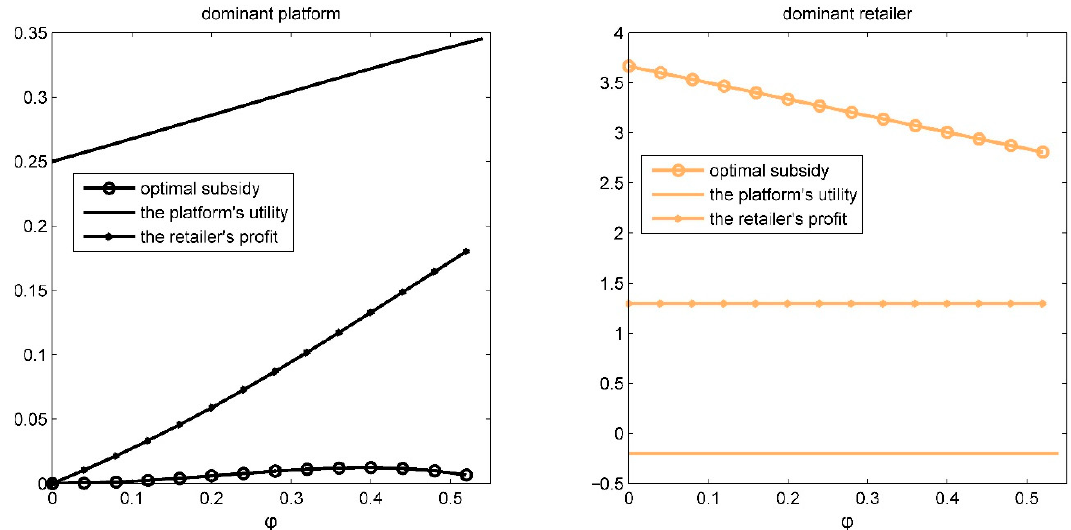
Figure 7. Optimal sales subsidy, the platform’s utility, and the retailer’s profit under different power structures with the change of φ .